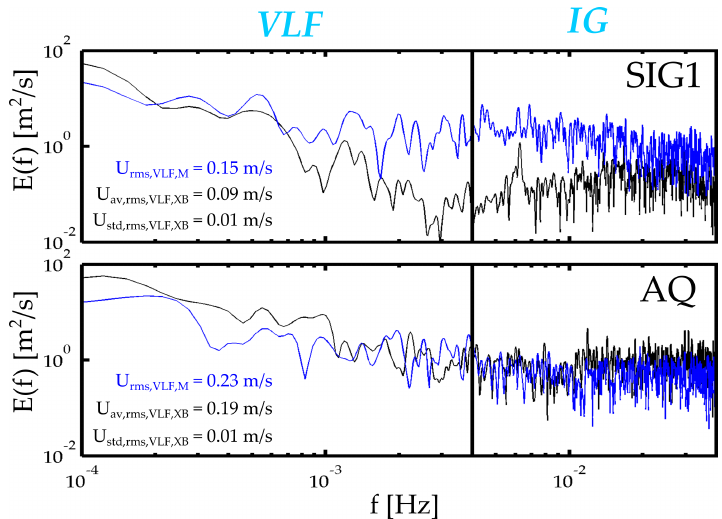
Figure 8. Modelled (black; one simulation) and measured (blue) velocity magnitude spectrum at low tide of event D2. Black vertical lines indicate the very low frequency band (VLF; f < 0.004 Hz) and the infragravity band (IG; 0.004 Hz < f < 0.04 Hz) at SIG1 and AQ ( top and bottom pan- els, respectively). For each panel, the root mean square VLF velocity magnitudes U rms,VLF com- puted following Reniers et al. [28] are indicated. U rms,VLF,M is the data while U av,rms,VLF,XB and U std,rms,VLF,XB are the mean rms magnitude averaged over ten simulations and its corresponding standard deviation,